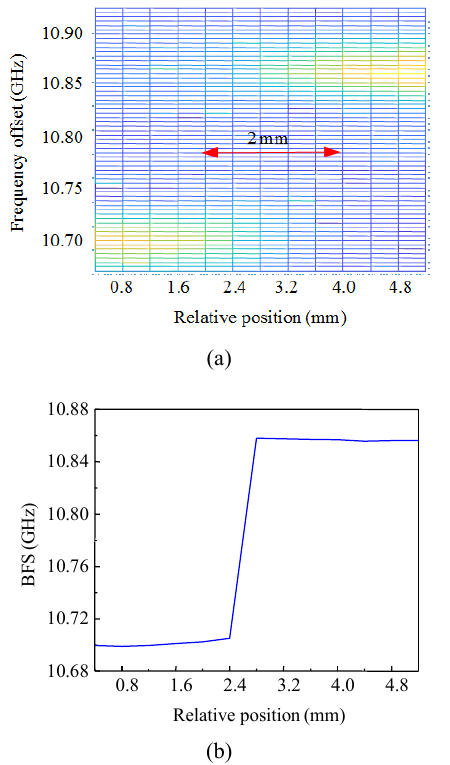
Fig. 5 Measured results of BOCAD: (a) measured Brillouin gain spectrum in the vicinity of the spliced joint of the fiber under test and (b) reconstructed local BFS [95].